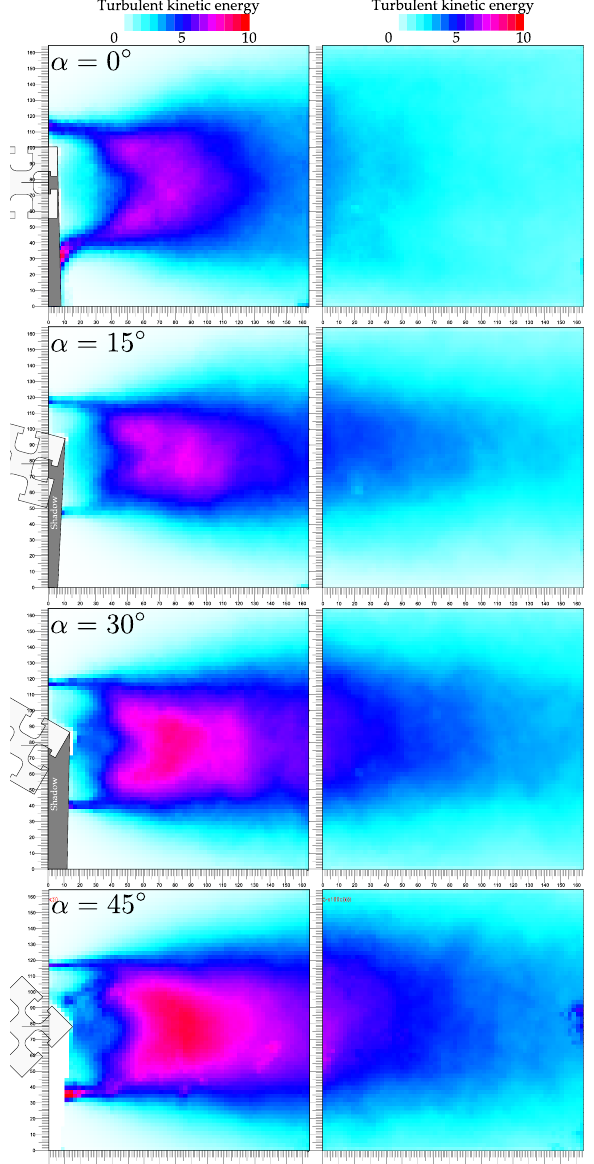
Fig. 4. Spatial distribution of the of the turbulent kinetic energy. Stream-wise velocity is 5 . 0m / s, corresponding Re = 1 . 5 · 10 4 . The angle of attack α is from top 0 ◦ , 15 ◦ , 30 ◦ and 45 ◦ respec- tively. The data at 45 ◦ contain more noise due to measuring dur- ing the sunny days.